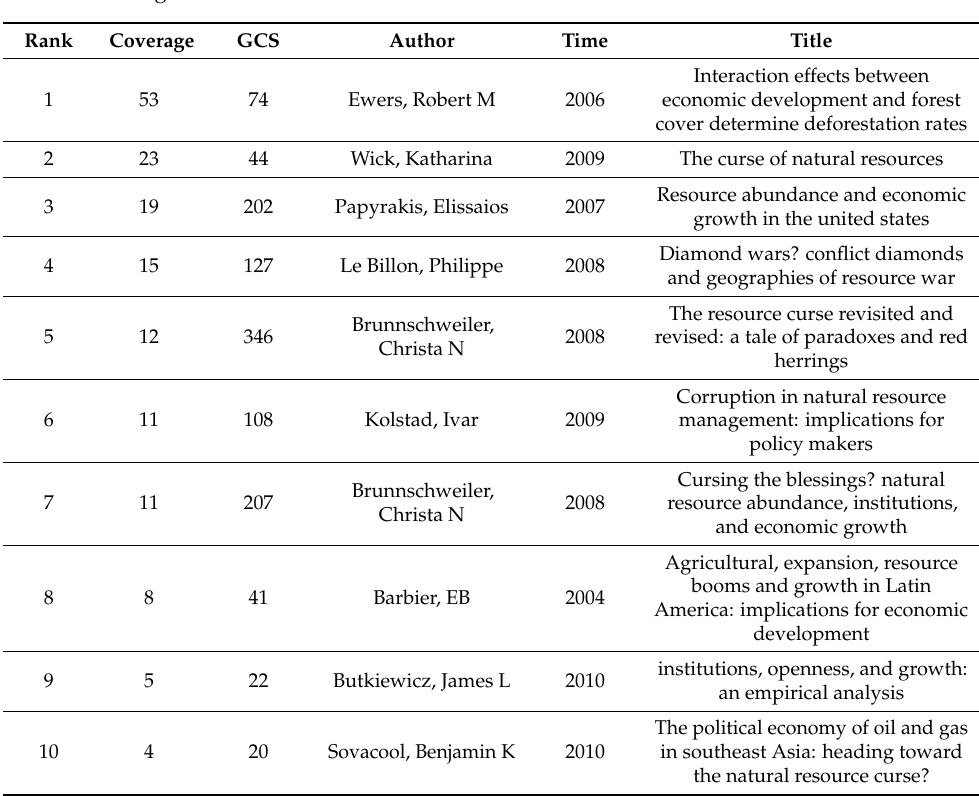
Table A8. Citing articles in Cluster